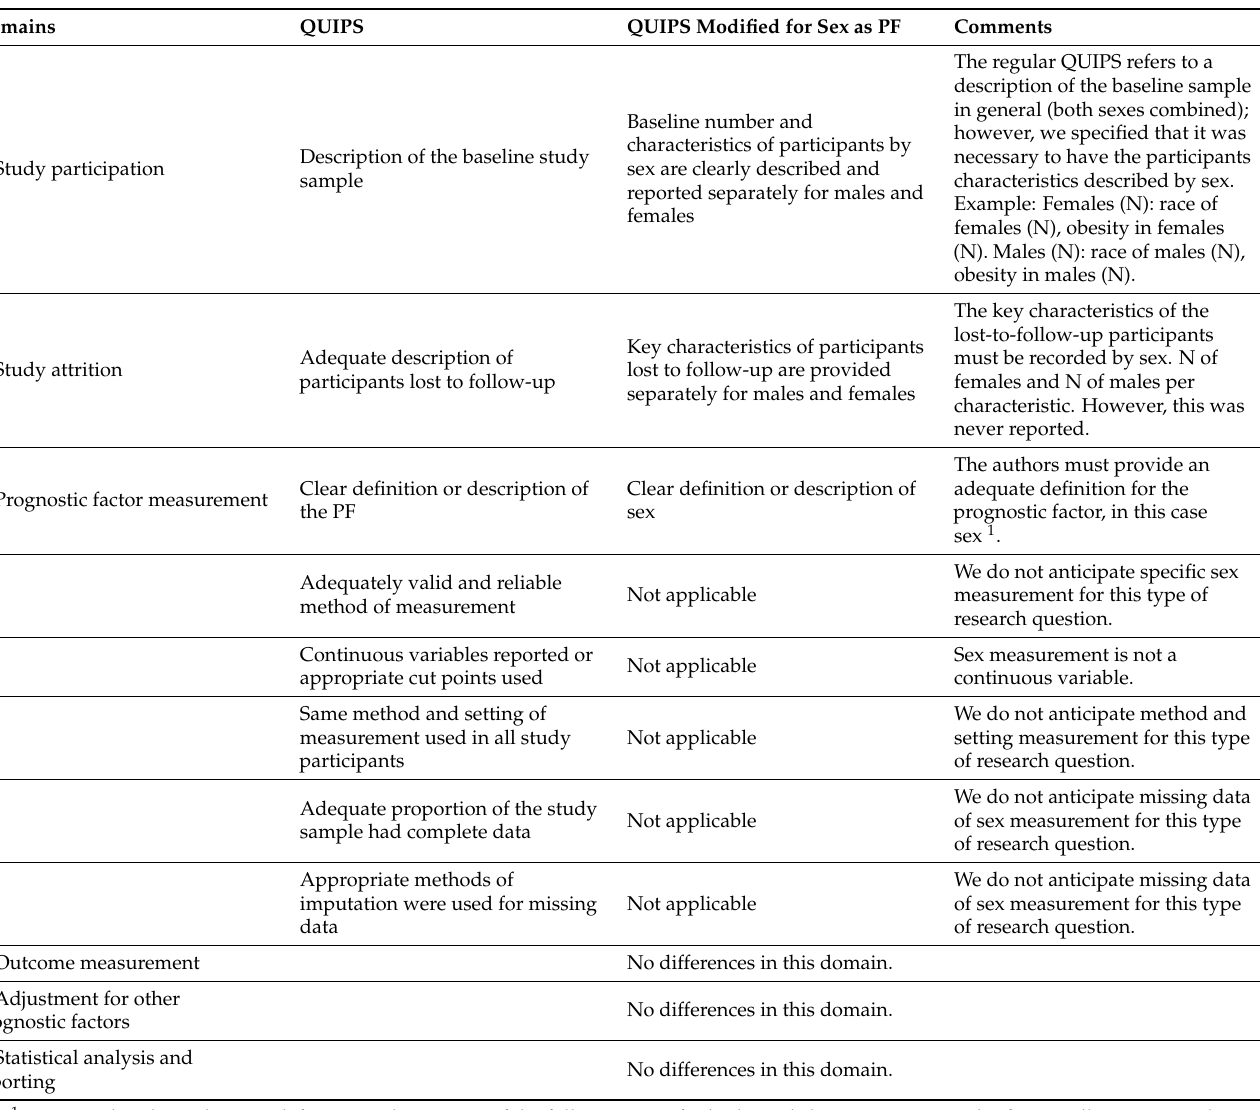
Table 1. QUIPS modifications for studying sex as a prognostic